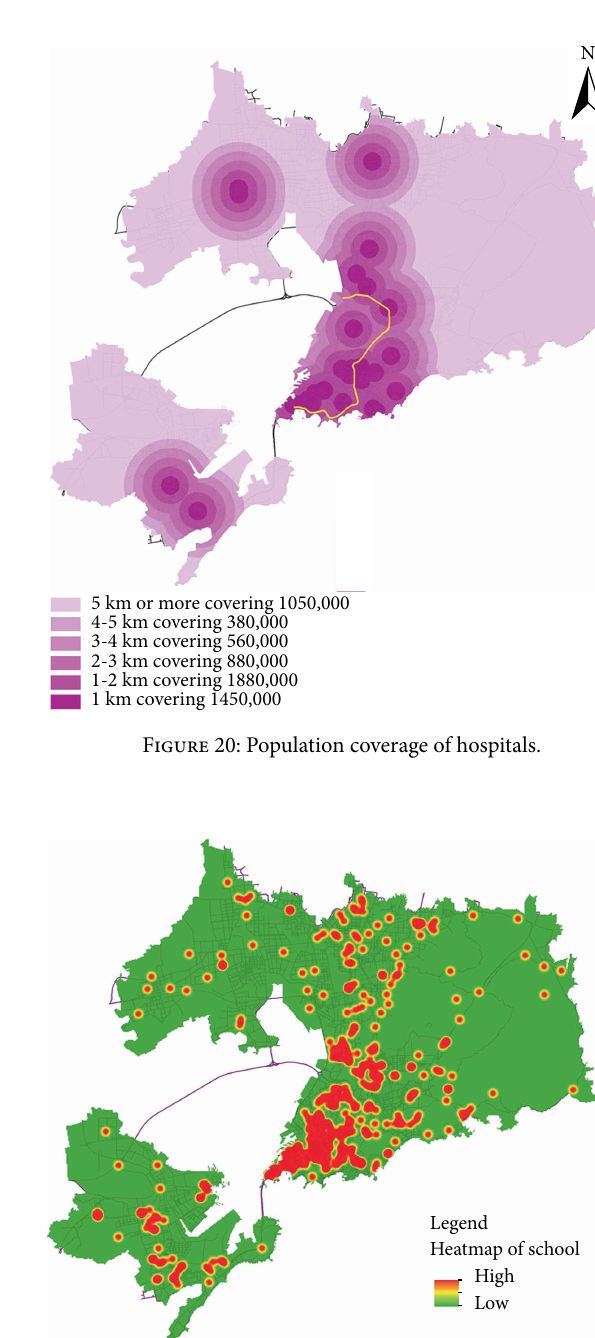
Figure 21: Distribution of